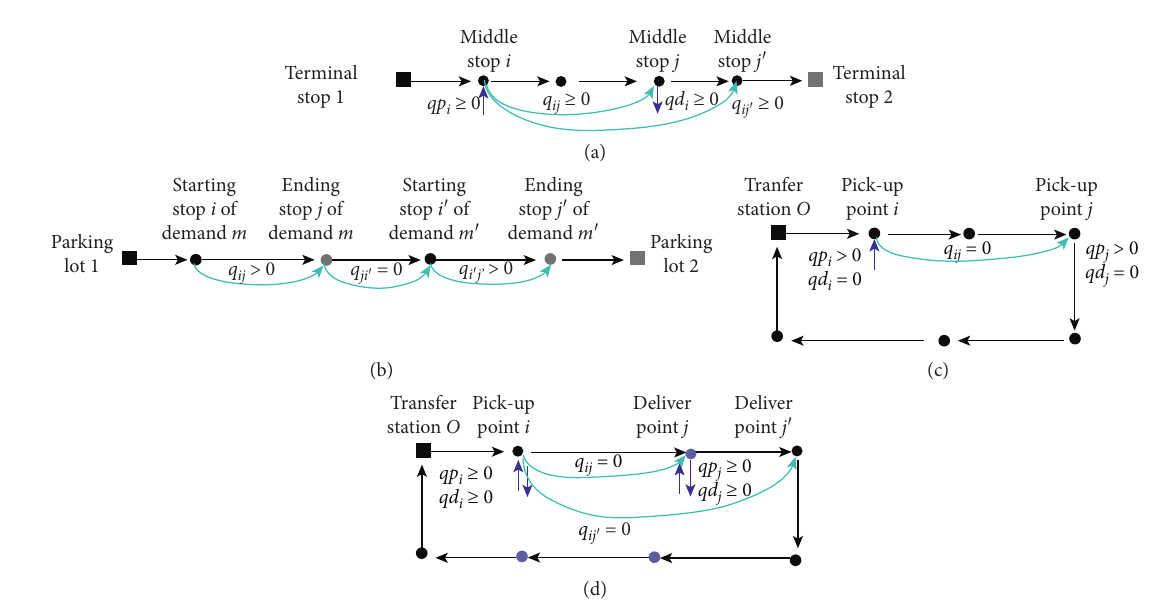
Figure 1: Four types of vehicle running modes ( q ij ( i or j ≠ o ) are the demands from stop i to stop j , and qp i and qd i are the number of pick-up or deliver passengers in the stop i , respectively). (a) Type A. (b) Type B. (c) Type C. (d) Type